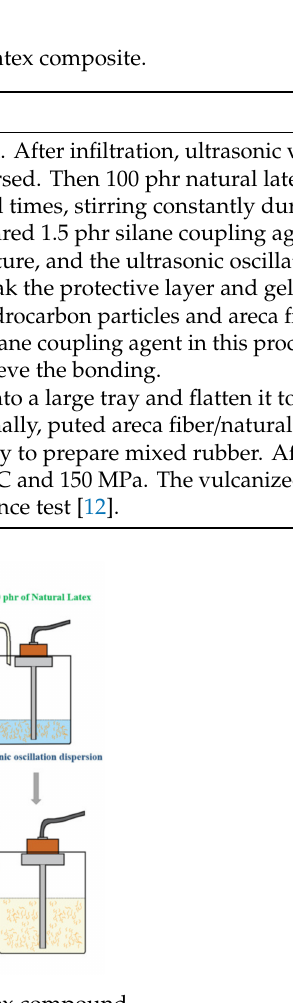
Figure 3. Process of areca fiber / natural latex